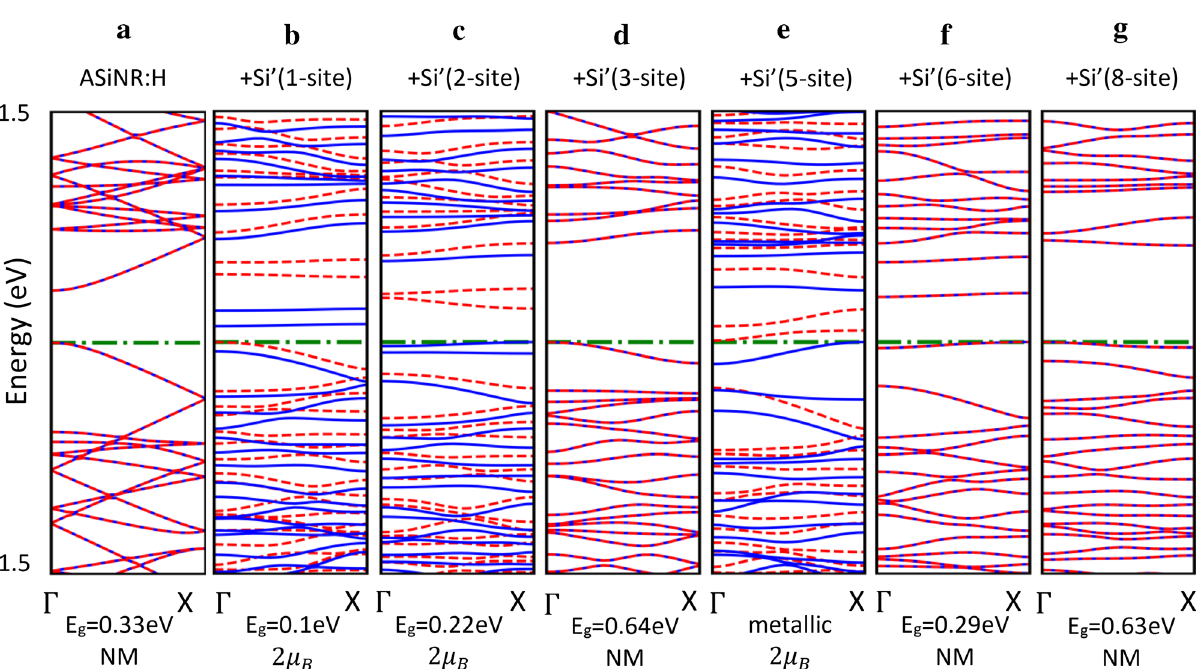
Figure 2. Effect of Si’ adsorption on the electronic and magnetic properties of ASiNRs:H. ( a ) Pure hydrogen saturated armchair nanoribbon, between ( b ) and ( g ) are the same nanoribbon with Si’ atom adsorbed on the top of site 1, 2, 3, 5, 6, and 8. The Fermi-level is set a zero. The dashed red and solid blue lines are spin-up and spin- down bands, respectively. E g and NM stand for the band gap and nonmagnetic, respectively.